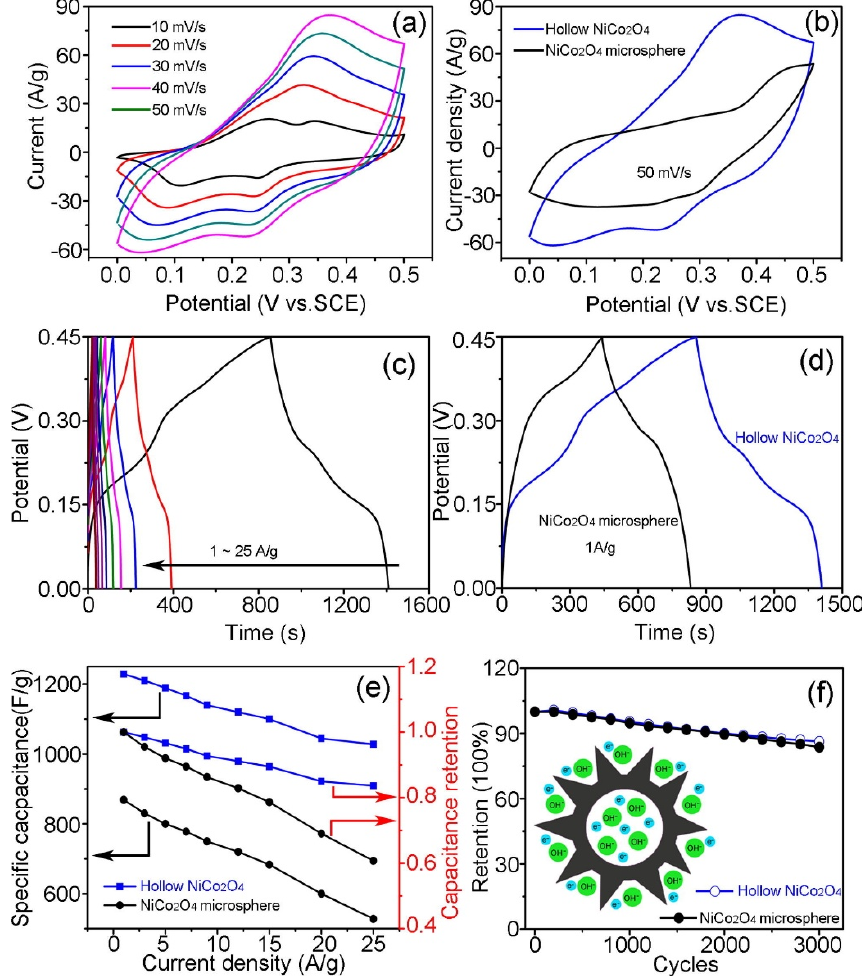
Figure 4. Hollow NiCo 2 O 4 nanospheres’ characteristic curve. ( a ) CV curves of the hollow NiCo 2 O 4 nanospheres at varied scan rates, ( b ) CV curves of the hollow NiCo 2 O 4 nanospheres and NiCo 2 O 4 microspheres at a scan rate of 50 mV/s, ( c ) CD curves of the hollow NiCo 2 O 4 nanospheres at different current densities, ( d ) CD curves of the hollow NiCo 2 O 4 nanospheres and NiCo 2 O 4 microspheres at a current density of 1 A/g, ( e ) The specific capacitances and capacitance retentions of the hollow NiCo 2 O 4 nanospheres and NiCo 2 O 4 microspheres, ( f ) Cycle performance of the hollow NiCo 2 O 4 nanospheres and NiCo 2 O 4 microspheres at 50 mV/s for 3000 cycles. Inset is schematic of the charge storage advantage of the hollow NiCo 2 O 4 nano-spheres. Reprinted with permission from Ref. [86]. Copyright 2017, Elsevier Inc.